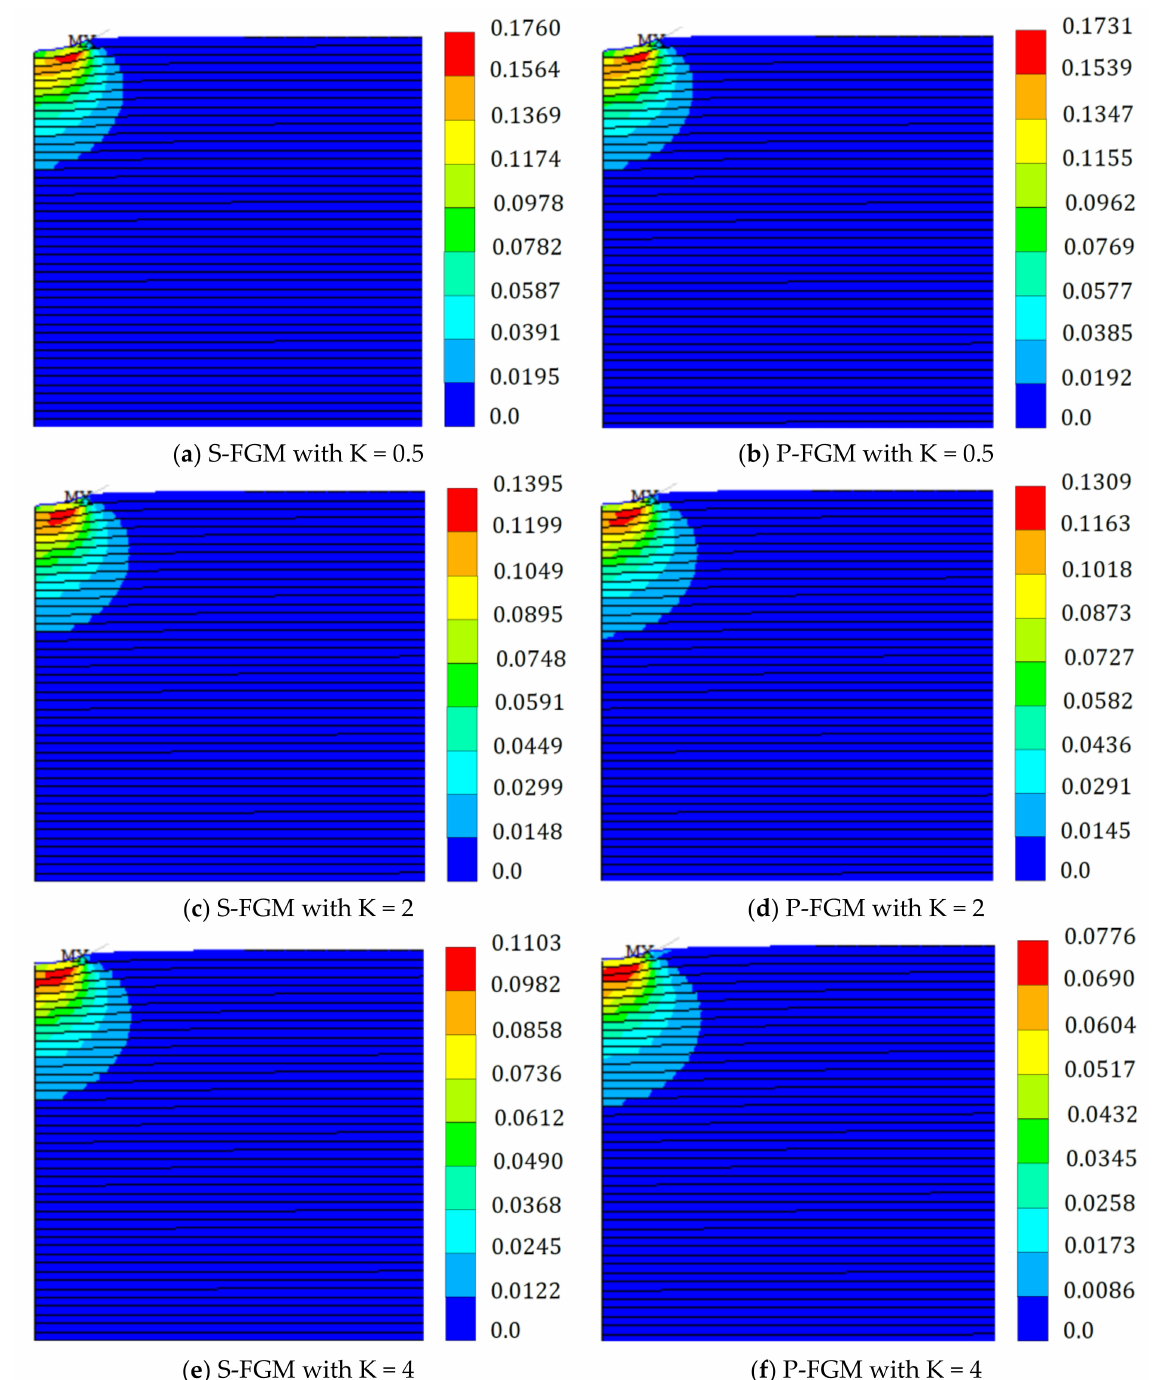
Figure 10. Distributions of the equivalent plastic strain (at full load) within the elastoplastic Ti/TiB specimen at different gradient indices; ( a ) Equivalent plastic strain of S-FGM at K = 0.5, and ( b ) Equivalent plastic strain of P-FGM at K = 0.5. ( c ) Equivalent plastic strain of S-FGM at K = 2, and ( d ) Equivalent plastic strain of P-FGM at K = 2. ( e ) Equivalent plastic strain of S-FGM at K = 4, and ( f ) Equivalent plastic strain of P-FGM at K =